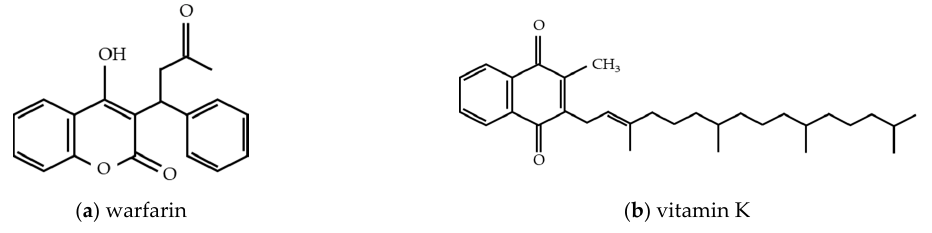
Figure 2. The chemical structure of ( a ) warfarin and vitamin ( a )